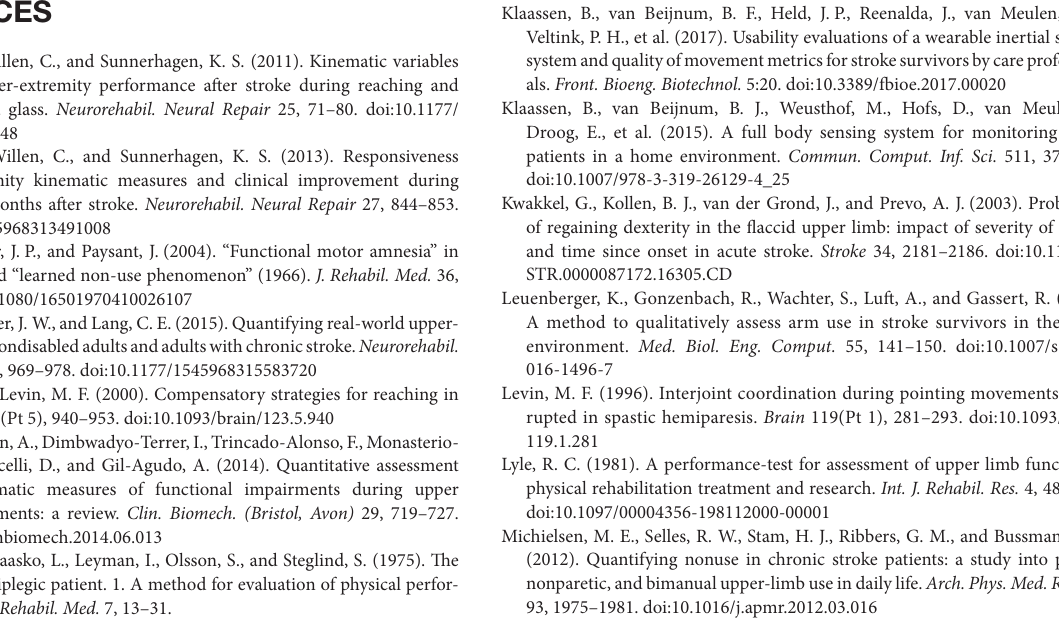
FigUre s1 | The distribution of the hand position relative to the pelvis (colors indicate the total time during the selected time slot at which the hand is in a certain position: dark red = most frequent position, blue = least-frequent position) of P1 at the three different stages in the rehabilitation process during self-directed activities of daily living. The encircled trajectory (left hand = green, right hand = red) determine the reaching area of the patient. FigUre s2 | The distribution of the hand position relative to the pelvis (colors indicate the total time during the selected time slot at which the hand is in a certain position: dark red = most frequent position, blue = least-frequent position) of P3 at the three different stages in the rehabilitation process during self-directed activities of daily living. The encircled trajectory (left hand = green, right hand = red) determine the reaching area of the patient. FigUre s3 | The distribution of the hand position relative to the pelvis (colors indicate the total time during the selected time slot at which the hand is in a certain position: dark red = most frequent position, blue = least-frequent position) of P4 at the three different stages in the rehabilitation process during self-directed activities of daily living. The encircled trajectory (left hand = green, right hand = red) determine the reaching area of the